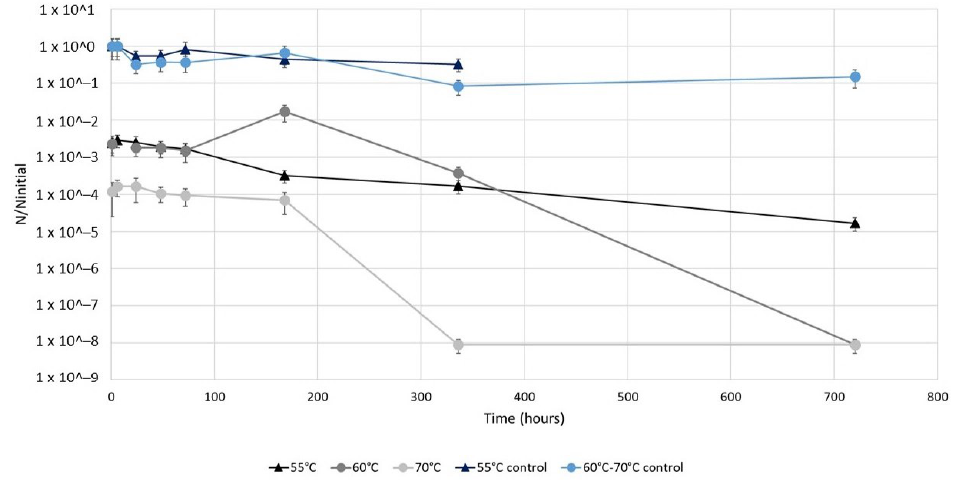
Figure 1. Temporal evolution of the ratio of the concentrations of culturable L. pneumophila in samples after a 1 h heat treatment at 55 ◦ C, 60 ◦ C or 70 ◦ C on the initial concentrations of culturable L. pneu- mophila in respective controls left at 36.5 ± 0.5 ◦ C. Experiments were conducted on an environmental L. pneumophila strain previously starved in simulated drinking water at room temperature. After the 1 h heat shock, bacteria were stored at 36.5 ± 0.5 ◦ C for up to 1 month. L. pneumophila concentrations in control suspensions left at 36.5 ± 0.5 ◦ C during